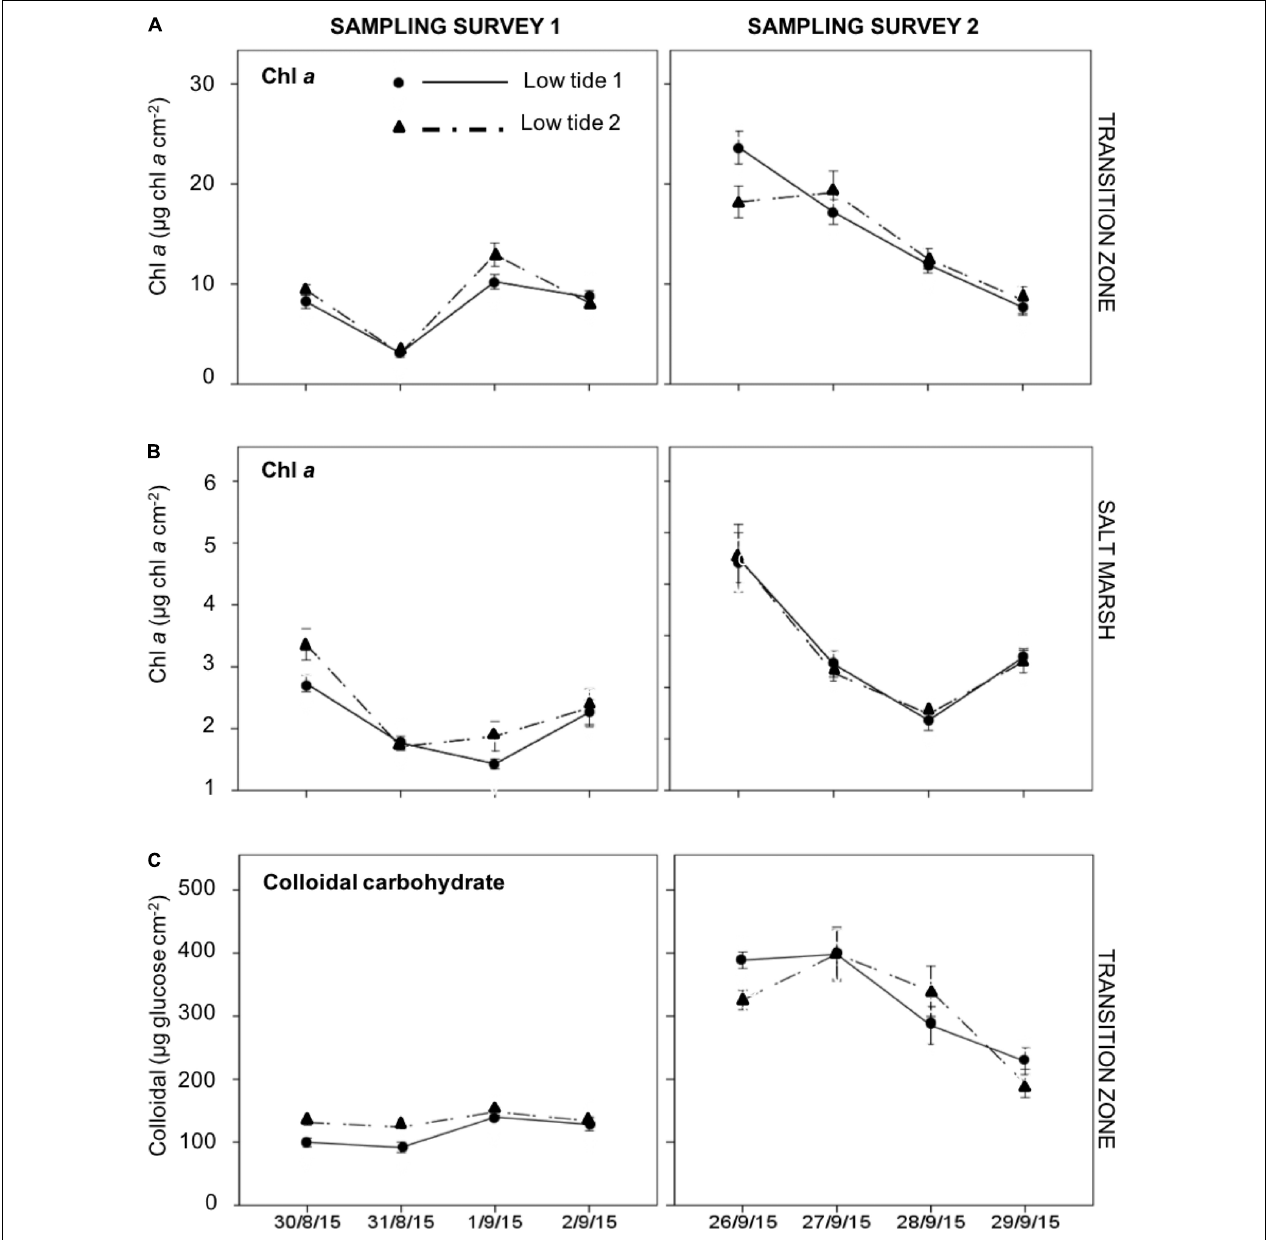
FIGURE 2 | Daily changes in Chl a concentration ( µ g cm - 2 ) in the top 2-mm sediment surface on the; (A) transition zone of the mudflat; (B) salt marsh; and (C) colloidal carbohydrate on the transition zone, sampled during low tide 1 (LT1) and low tide 2 (LT2) in sampling survey 1 and survey 2 at Fingringhoe Wick, Colne Estuary, Essex, United Kingdom, in August and September 2015. Values are mean ± SE, n = 5.